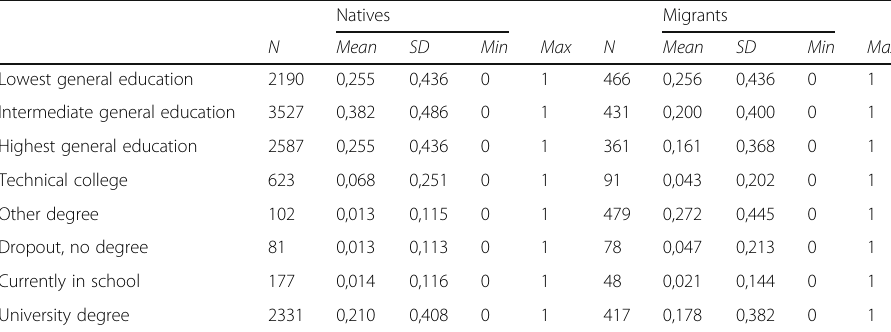
Table 2 Educational degrees: natives vs. migrants Natives